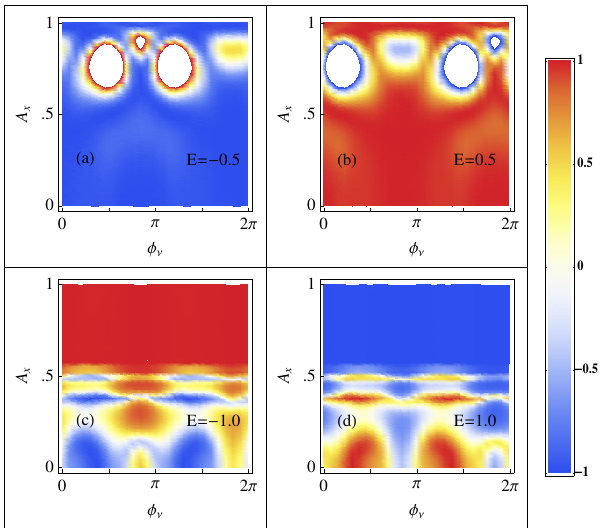
Figure 7. Simultaneous variation (density plot) of P with AAH phase φ ν and light parameter A x at some specific energies. Here we set θ i = 0 ∀ i